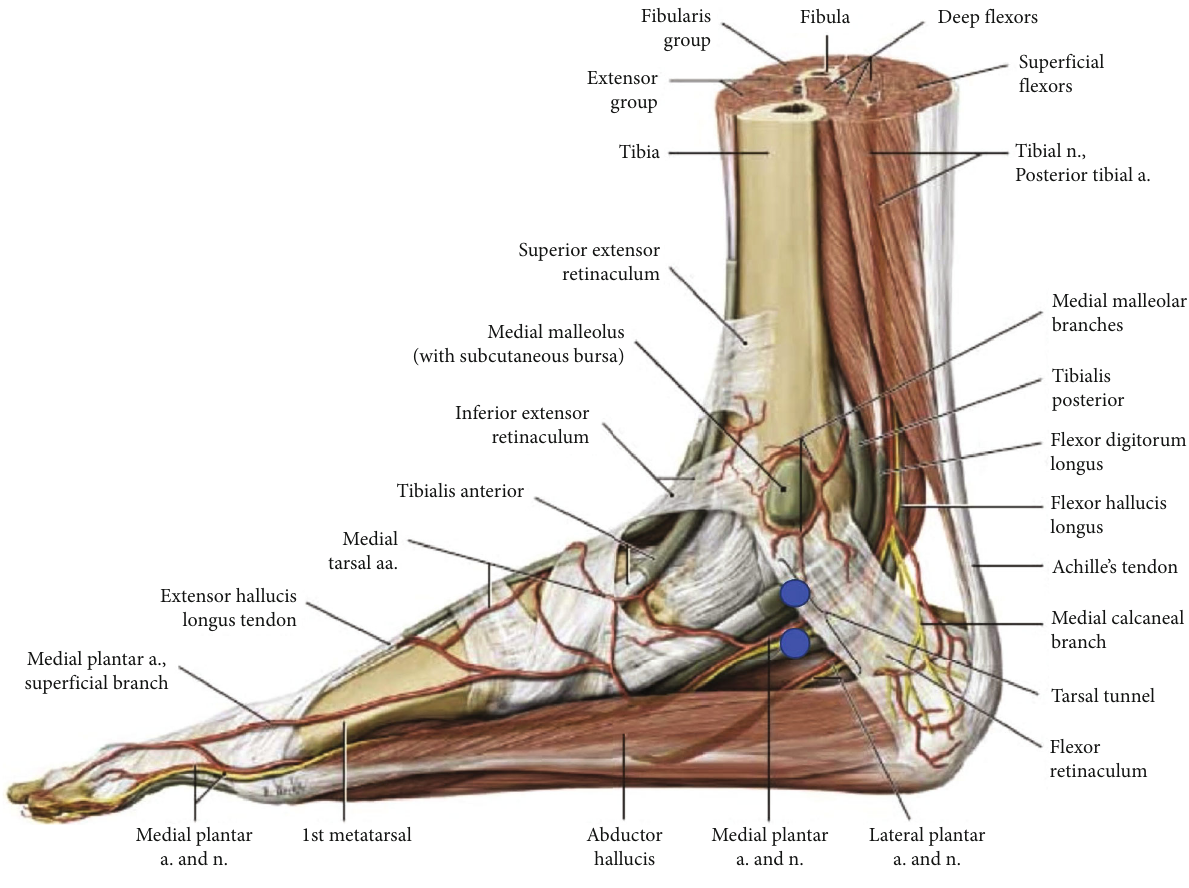
Figure 4: Anatomy of the medial ankle [18].